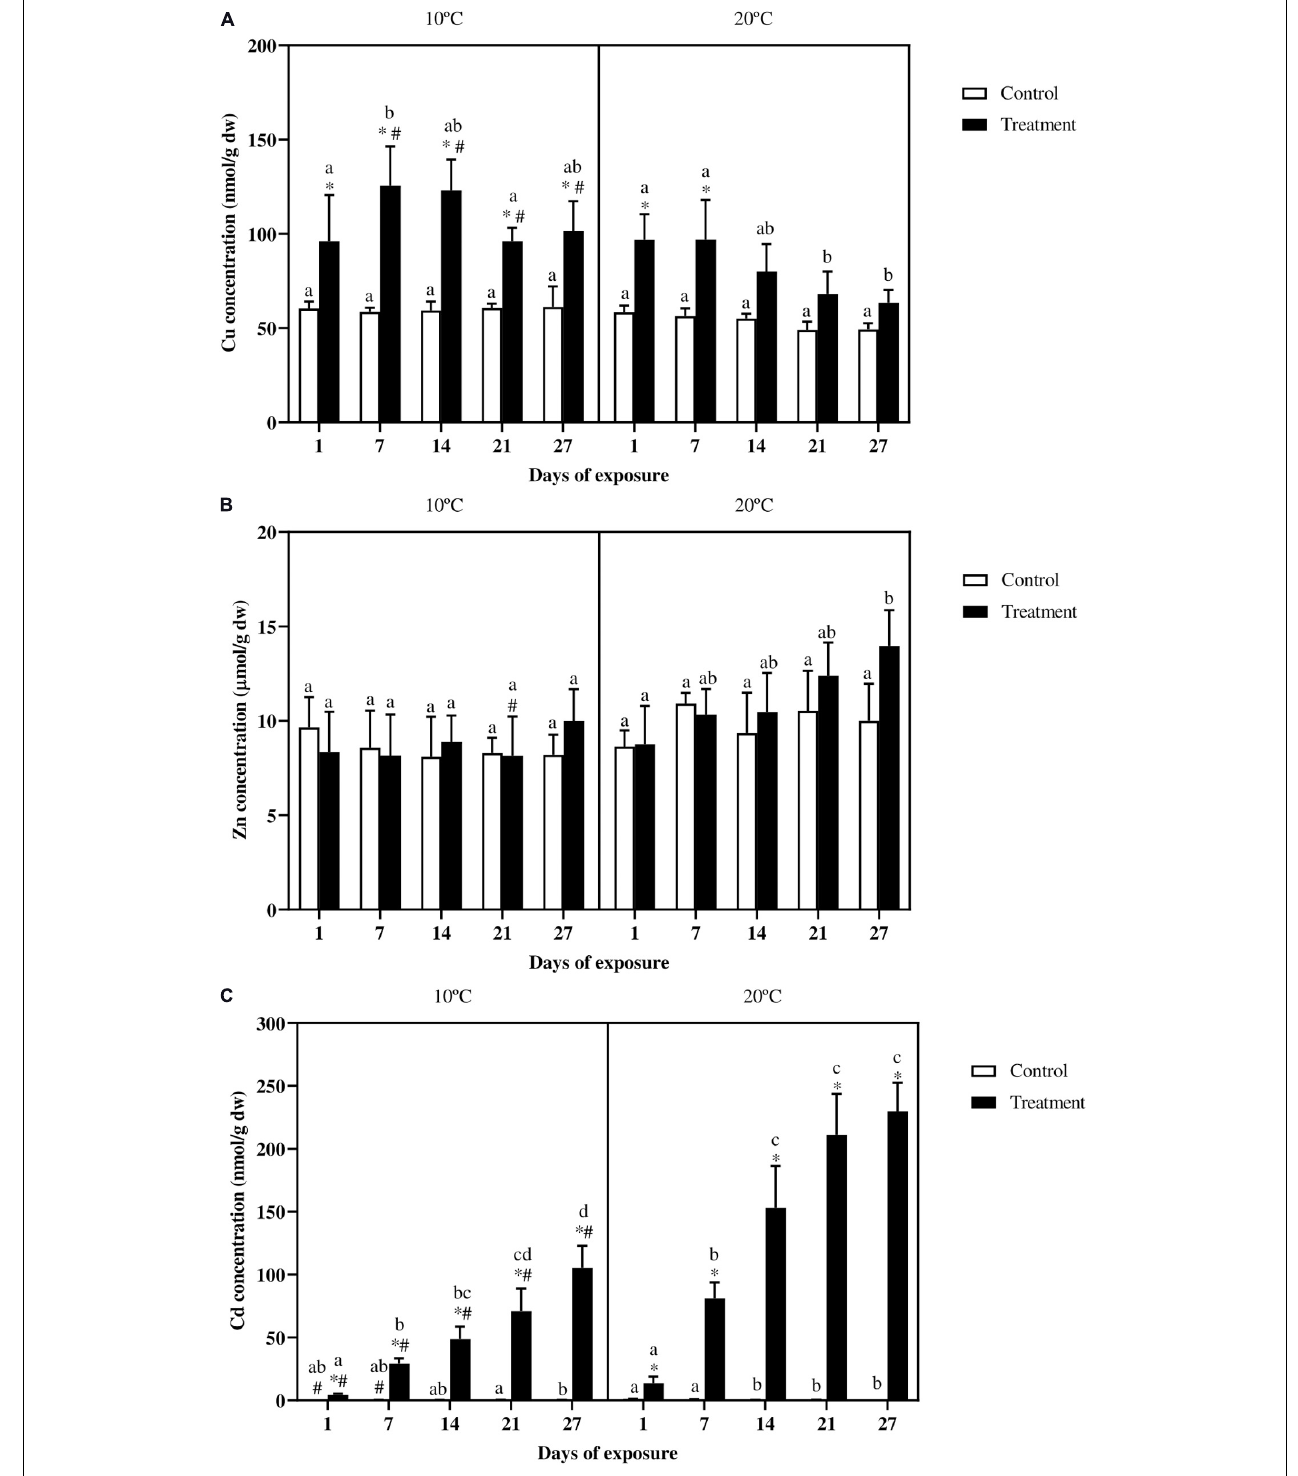
FIGURE 2 | Gills (A) Cu (nmol/g dw), (B) Zn ( µ mol/g dw), and (C) Cd (nmol/g dw) accumulation in common carp exposed to a mixture of Cu, Zn, and Cd for 27 days both at 10 ◦ C and 20 ◦ C. Mean ± SD, N = 5. Mean + SD. Asterisks ( ∗ ) indicate differences between control and metal treatment at each sampling day, the hash (#) indicates differences between the same groups (both control and metal treated) at different temperatures, and lowercase letters indicate significant differences of the same group among sampling days at each temperature ( p < 0.05).